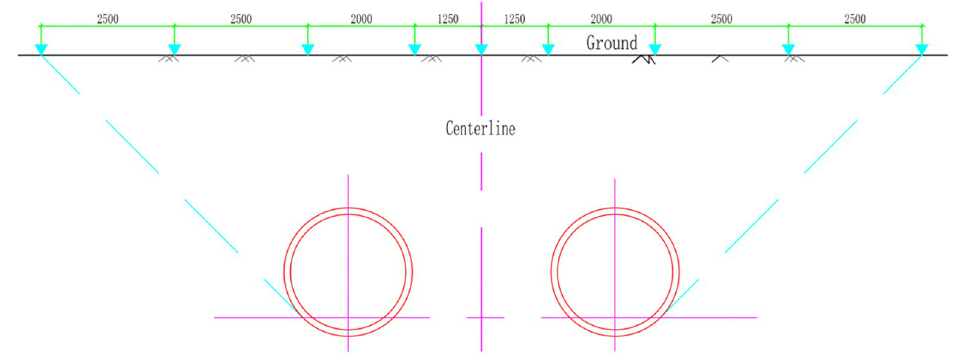
Fig 2. Cross-sectional monitoring point arrangement.